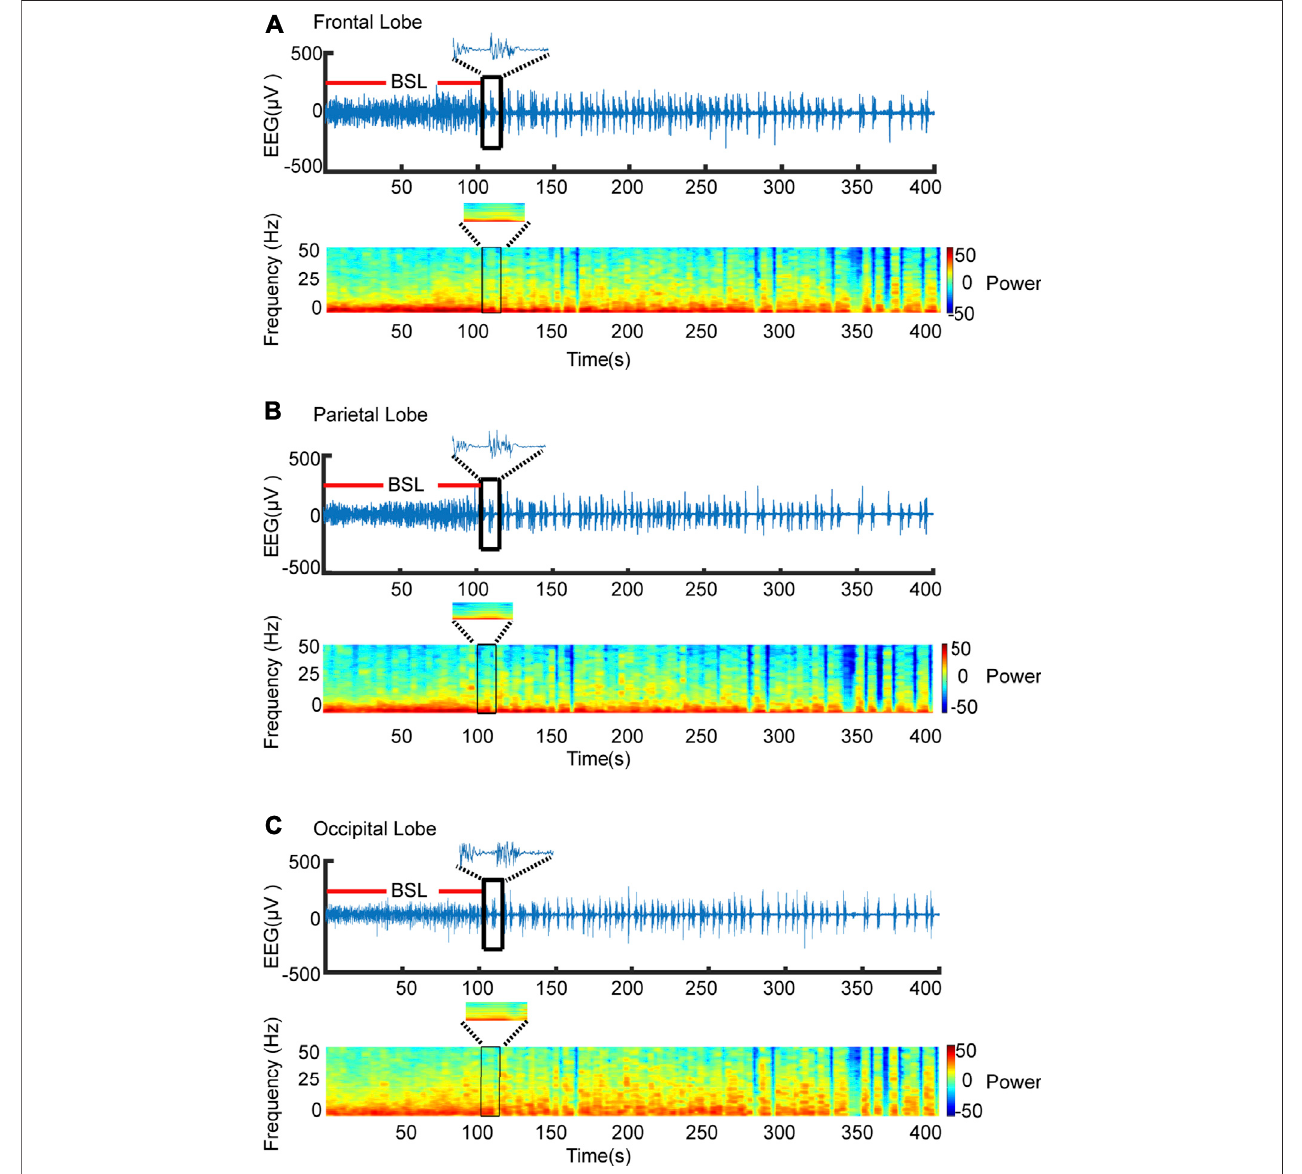
FIGURE 2 | Automatic recognition BSL. (A) Representative EEG raw traces (upper) and power spectrogram (lower) are shown for the occipital lobe. Software recognizes the fi rst burst-suppression as indicated by the black frame. The time from anesthesia induction to the fi rst burst-suppression, where periods of suppression were de fi ned as lasting more 0.5 s, was de fi ned as BSL. (B , C) Raw and spectrogram maps of the frontal, parietal and occipital, respectively.